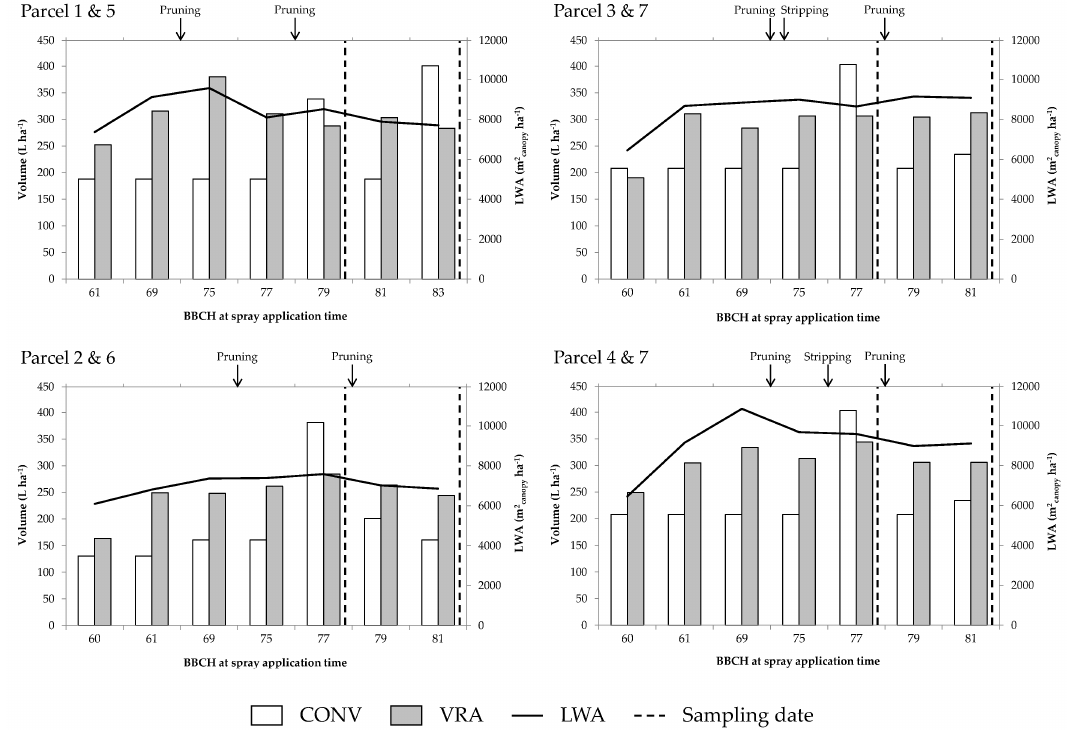
Figure 11. Volume rate applied in conventional and variable rate parcels in each spray application. Time of the evaluation of the biological e ffi cacy (sampling time) as well as pruning and stripping task are marked.